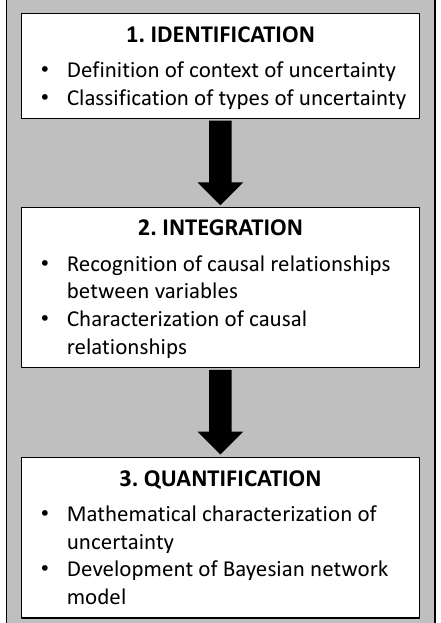
Figure 3. Framework for uncertainty analysis.